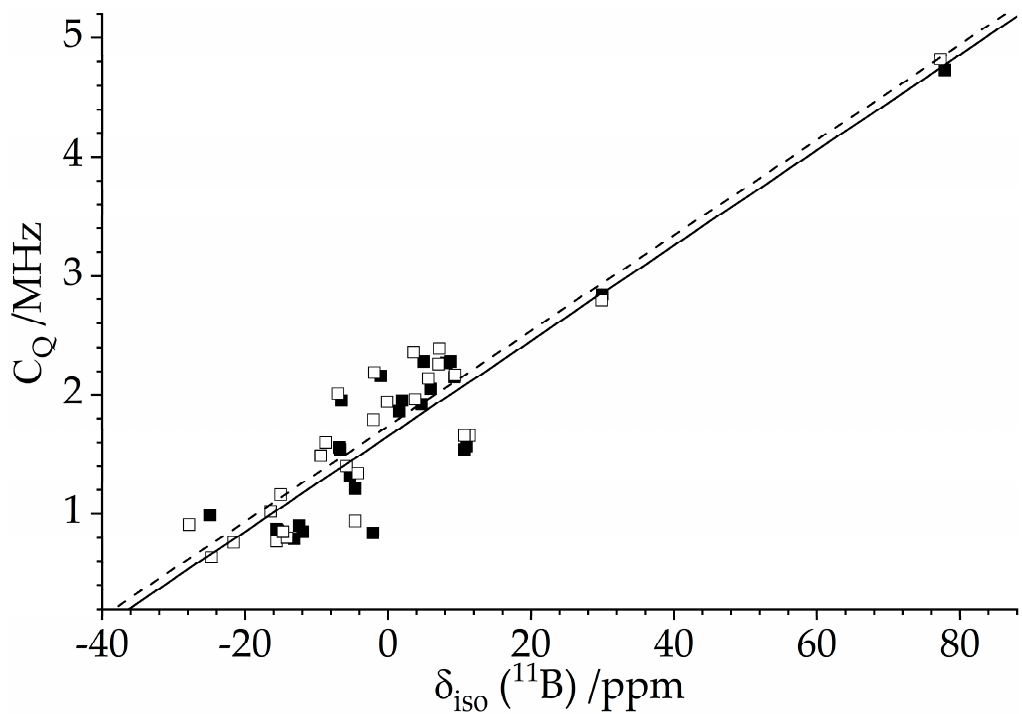
Figure 15. Correlation of 11 B isotropic chemical shifts and 11 B nuclear electric quadrupole coupling constants for vicinal B / P FLPs [78,79]. Closed symbols, solid line ( C Q = 1.652 MHz + 0.040 × δ / ppm; R 2 = 0.84): experimental data; open symbols, dashed line ( C Q = 1.738 MHz + 0.040 × δ /ppm; R 2 = 0.87): DFT-calculated values.